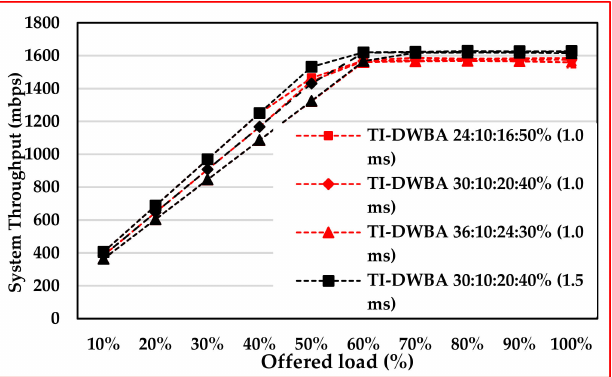
Figure 9. Overall system throughput in cycle time 1.0 (ms) and 1.5